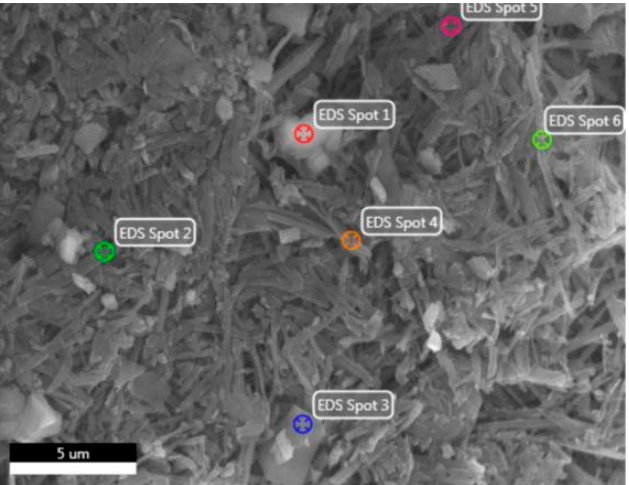
Figure 4. EDS image of PFWC-439/putty powder: spot 1 and spot 3 are the hydration products of the putty powder; spot 2, spot 4, spot 5 and spot 6 are MPM.